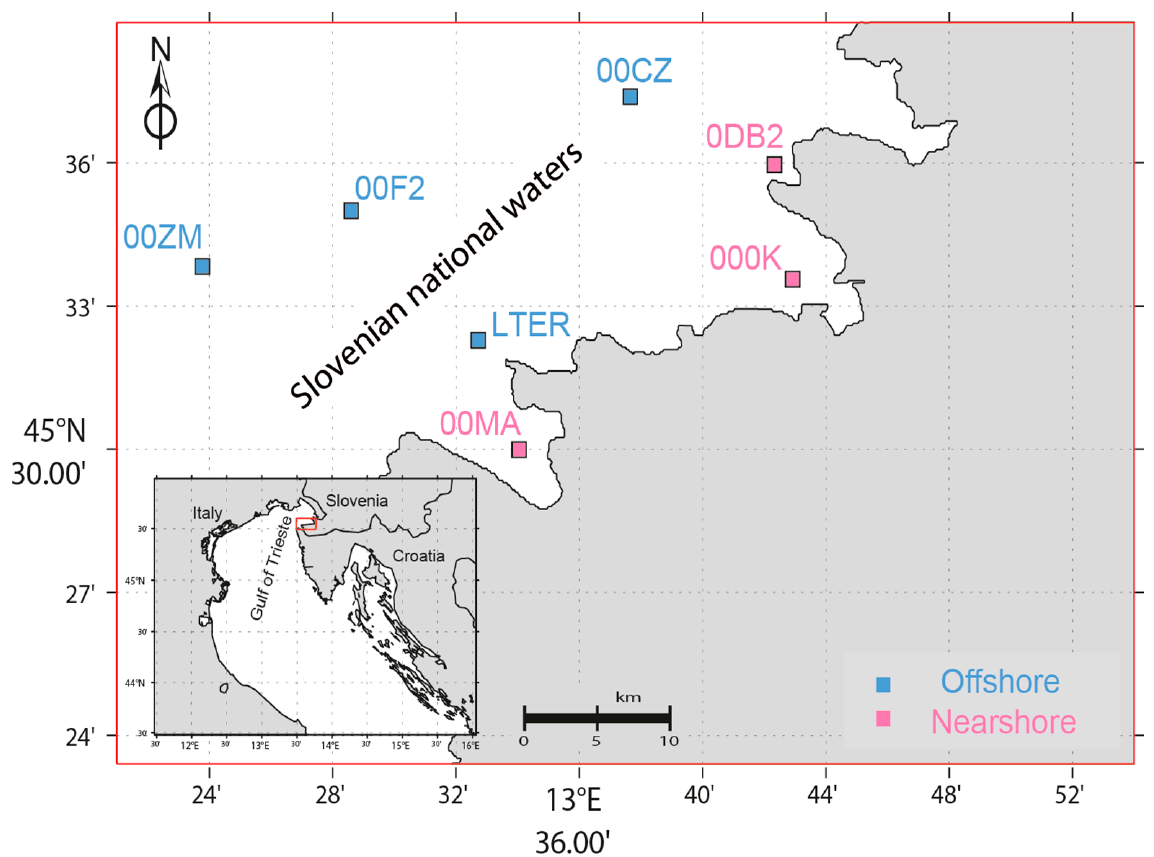
Figure 1. Study area and sampling stations in the Slovenian national waters within the Gulf of Trieste, northern Adriatic Sea (inset), which are part of the national monitoring program of the ecological status of the sea.